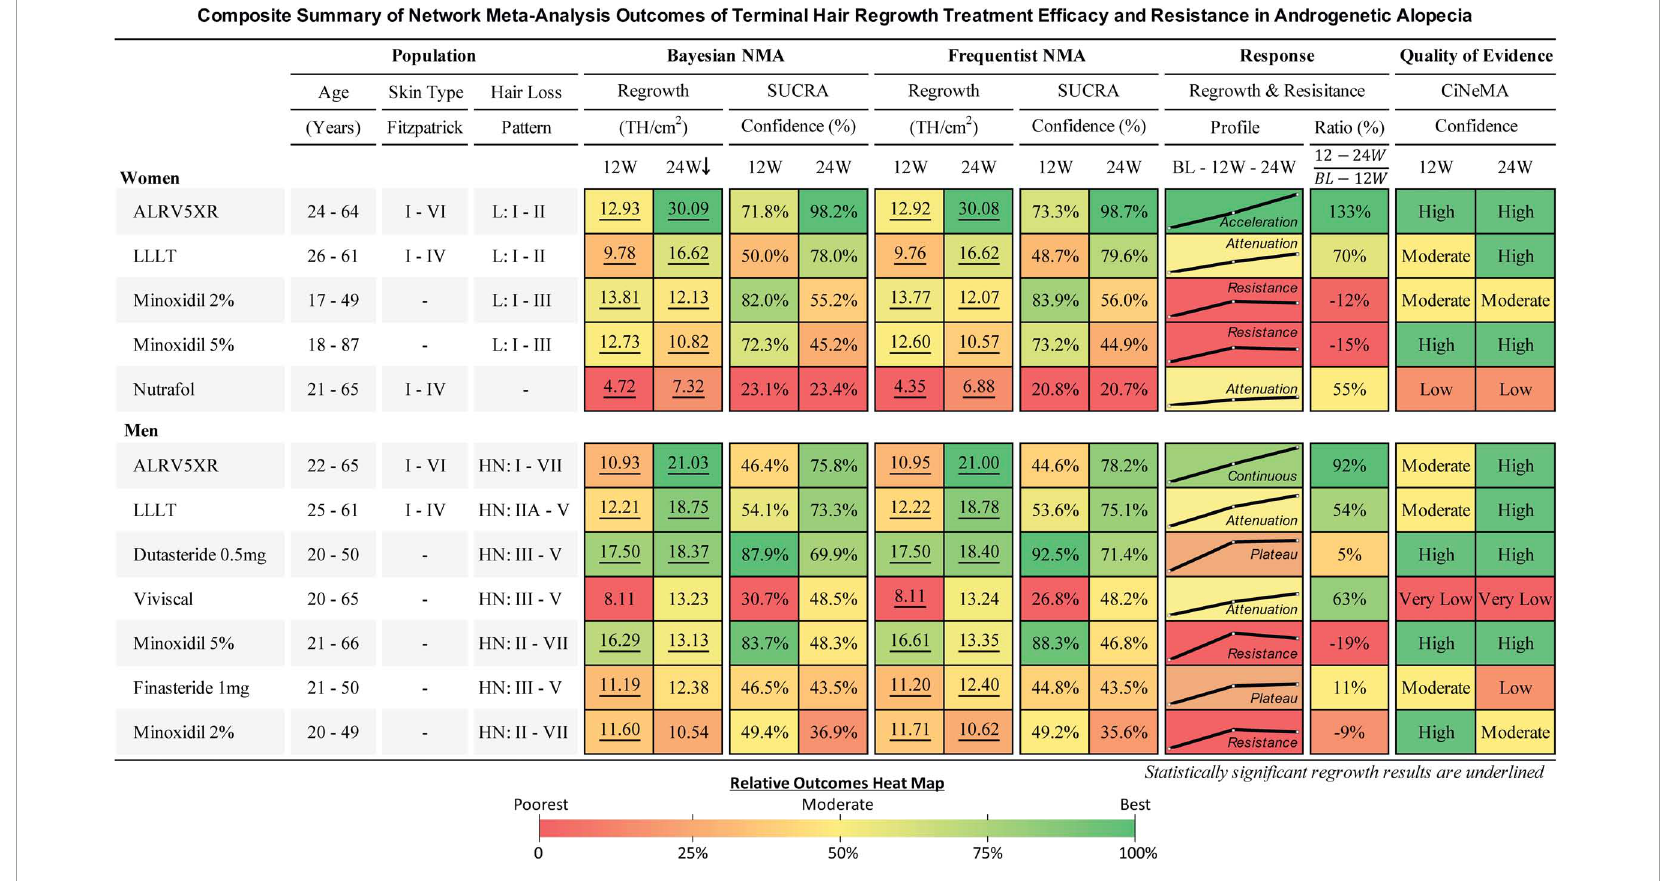
FIGURE4 Composite summary of terminal hair regrowth and resistance from network meta-analysis outcomes for treatments in androgenetic alopecia. This outcomes table provides an overview of the studied populations, Bayesian and frequentist network meta-analyses (NMAs), response profiles showing regrowth and resistance, and quality of evidence for each treatment. Women and men are ranked in descending order of efficacy at 24 weeks of the Bayesian NMA after 250,000 Markov Chain Monte Carlo simulations. Regrowth measures efficacy as mean difference (MD) in TH/cm 2 between each treatment and Placebo using direct and indirect comparisons at 12 and 24 weeks. Hair loss pattern: L = Ludwig (women), HN = Hamilton-Norwood (men). BL, 12W, and 24W refer to baseline, 12 weeks, and 24 weeks duration of treatment. SUCRA: surface under the cumulative ranking area measures relative confidence of outcomes of the compared treatments. Response Profile is a line graph connecting the treatment changes from baseline (BL) to MD at 12 and 24W. Y-axes (MD) are scaled 0–31 for women and 0–22 for men. Response Ratio (%) is change in regrowth of 12–24W compared to BL–12W. Quality of evidence is CiNeMA results using Cochrane risk of bias, GRADE scores, and study data. Heat maps are shared between each sex’s numerical result block and manually assigned to categorical